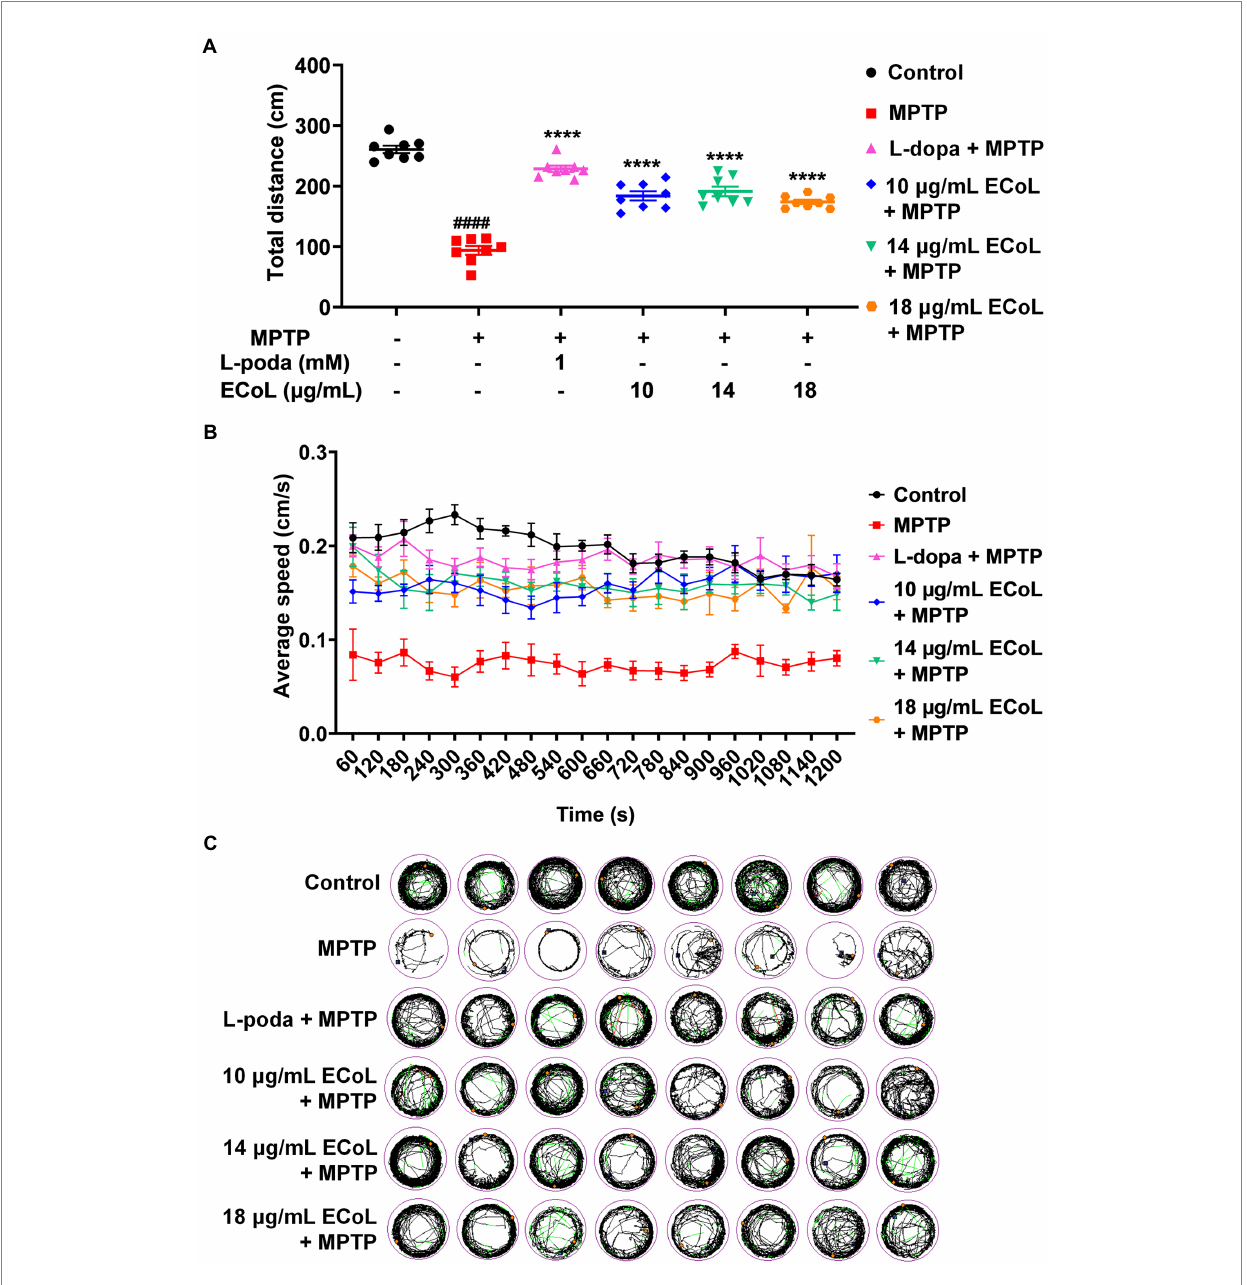
FIGURE 5 Improved effect of ECoL on MPTP-induced locomotor impairment. (A) The total distance moved for zebrafish in Control, MPTP, L-dopa+MPTP, and ECoL+MPTP co-treatment groups. n = 8 per group. #### p < 0.0001 vs. control; ****p < 0.0001 vs. MPTP. (B) Average speed of all individuals from each group. n = 8 per group. Average speed was calculated in every 60 s within the 20 min recorded duration. (C) The digital track map. Red, green, and black lines represent fast (> 0.5 cm/s), medium (0.2–0.5 cm/s), and slow (< 0.2 cm/s) movement trajectories, respectively. n = 8 per